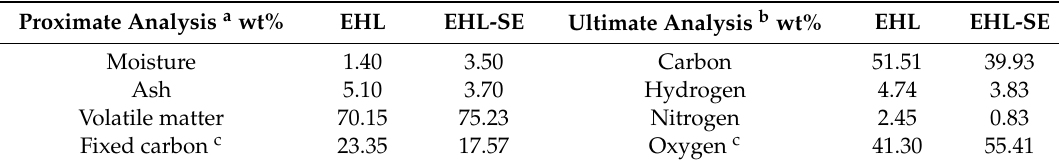
Table 4. Proximate and ultimate analysis of EHL and